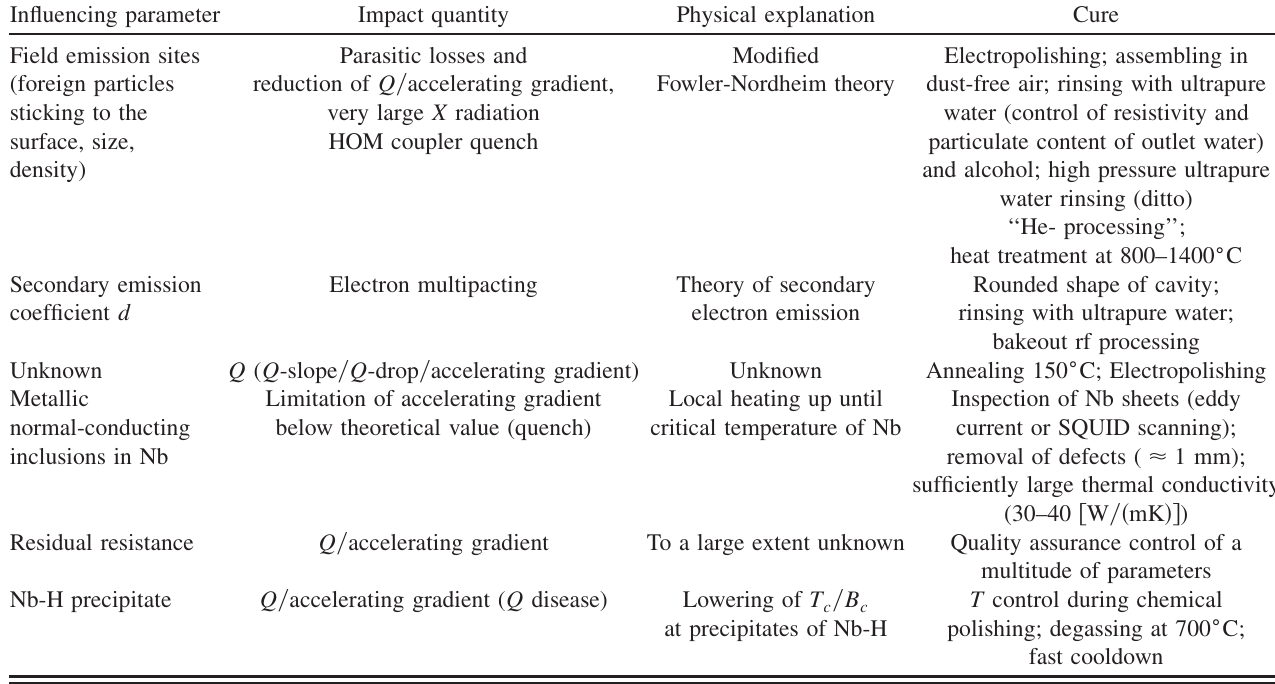
TABLE IX. Several stochastic parameters.